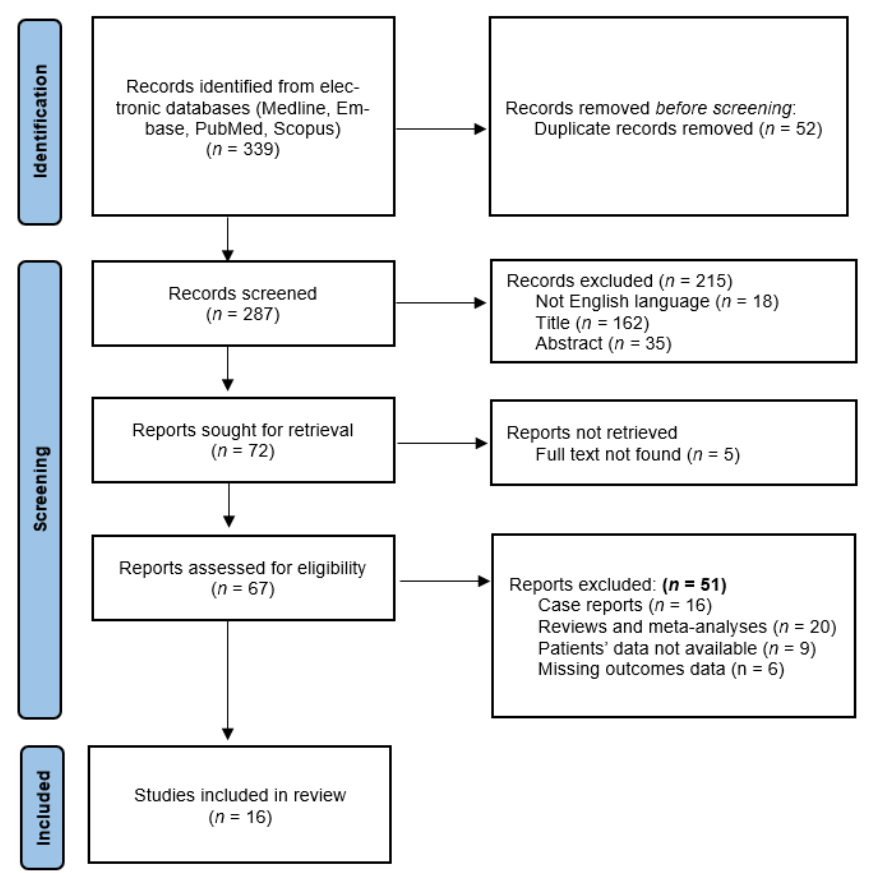
Figure 1. PRISMA 2020 flow diagram